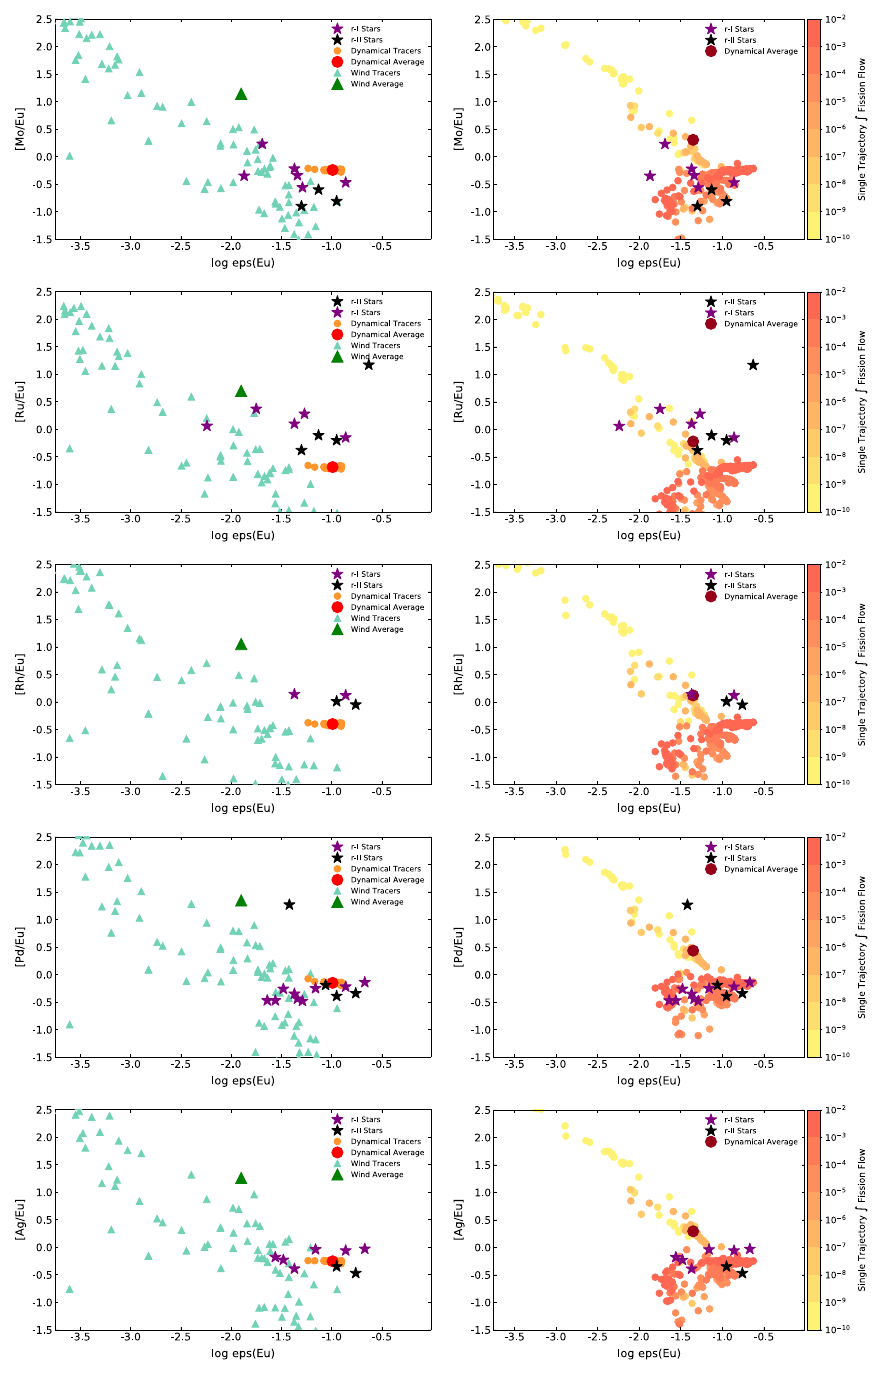
Figure 5. Calculation results for the elemental ratios of light heavy elements (Mo, Ru, Rh, Pd, and Ag) found to the left of the second r -process peak relative to the lanthanide element Eu found to the right of the peak (a subset of such plots was shown in [31]). Observational values for stars which are metal-poor, yet rich in r -process elements are shown for comparison. See text for